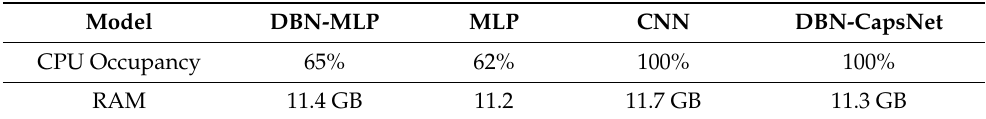
Table 4. Computational cost